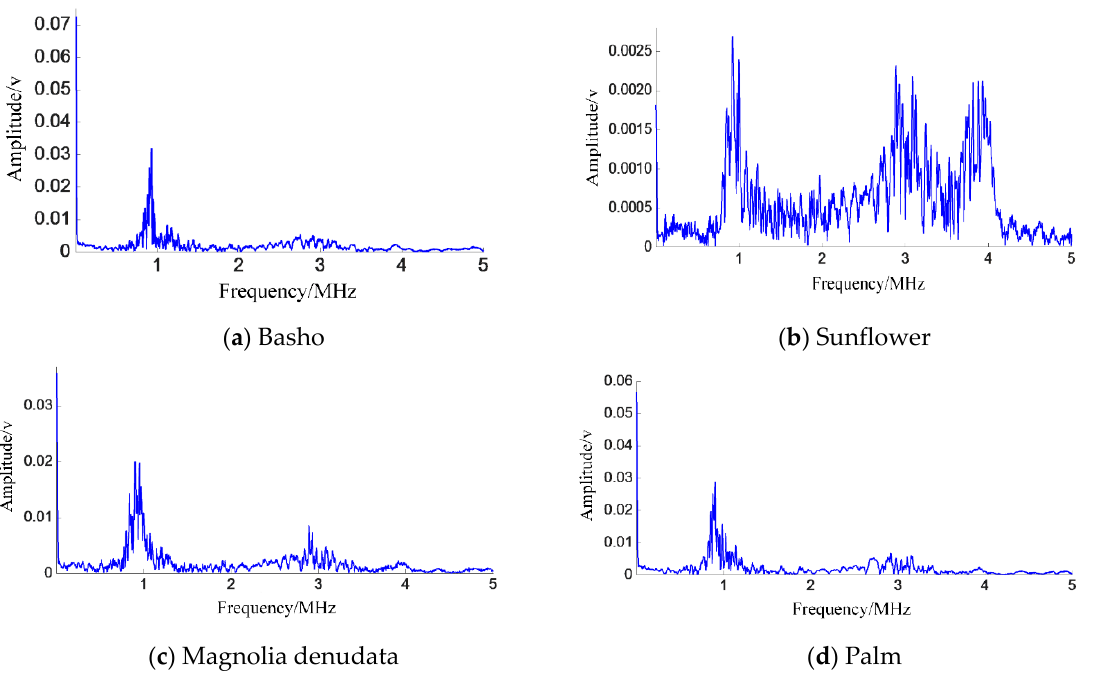
Figure 4. Ultrasound amplitude-frequency signals of plant stems.